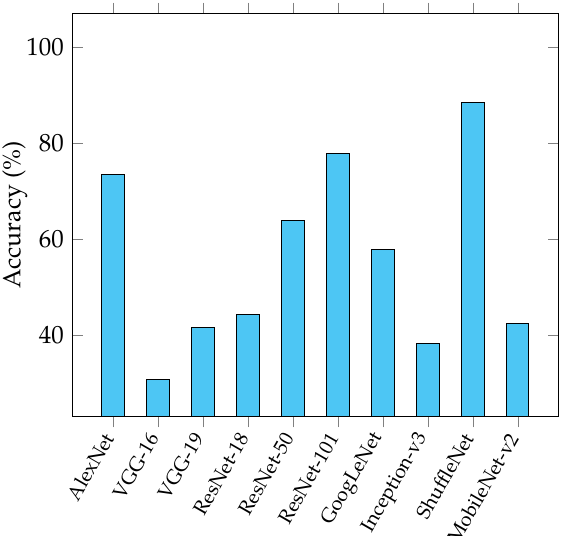
Figure 6. Classification accuracy obtained by the different CNNs adopted in the synthetic data set.